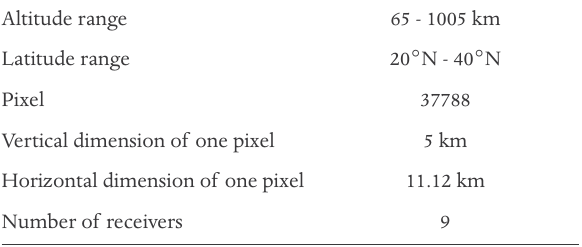
Table 1. Geometry for the reconstruction.